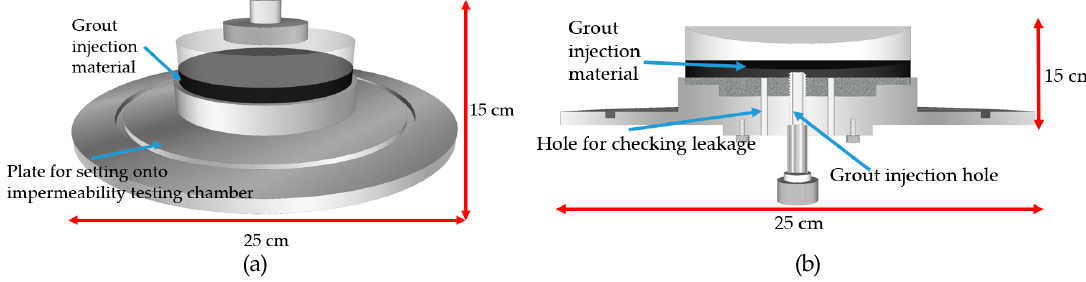
Figure 4. The specimen for thermal stress resistance, hydrostatic pressure resistance, and substrate behavioral stress resistance testing: ( a ) specimen concept and ( b ) specimen inner structure.